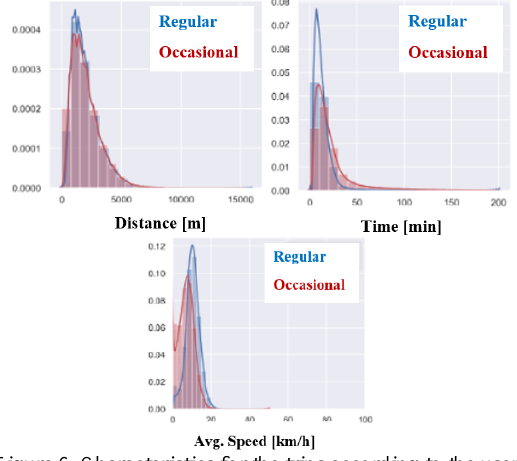
Figure 6. Characteristics for the trips according to the users typology